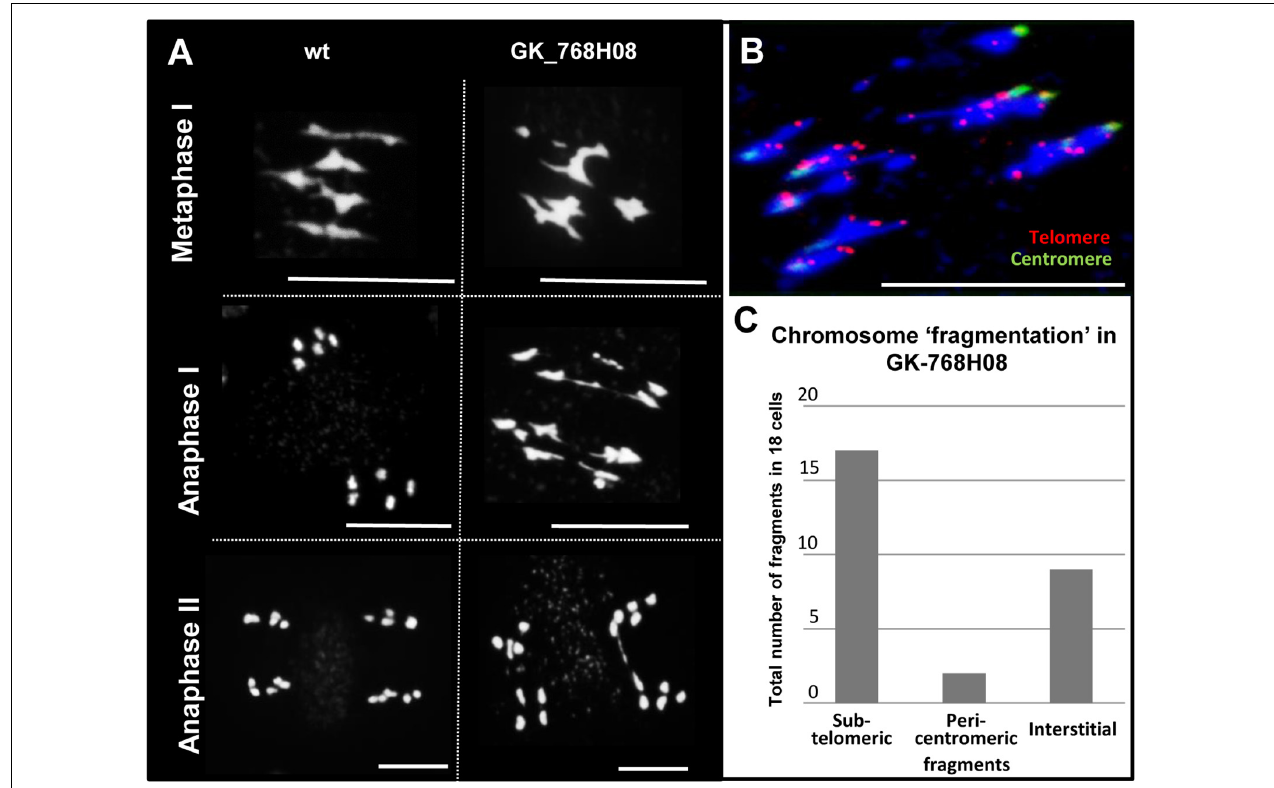
FIGURE 3 | Meiotic defects in the nse4 mutant GK-768H08. (A) Disturbed meiosis (anaphase bridges, fragments) in the A. thaliana mutant GK-768H08 compared to wild-type (wt). (B) Chromosome fragmentation in GK-768H08 during anaphase I. Telomeres and centromeres were labeled by FISH using centromere- and telomere-specific probes. (C) Total number of subtelomeric, pericentromeric, and interstitial chromosome fragments in 18 meiotic cells of the GK-768H08 mutant. Bars = 10 µ